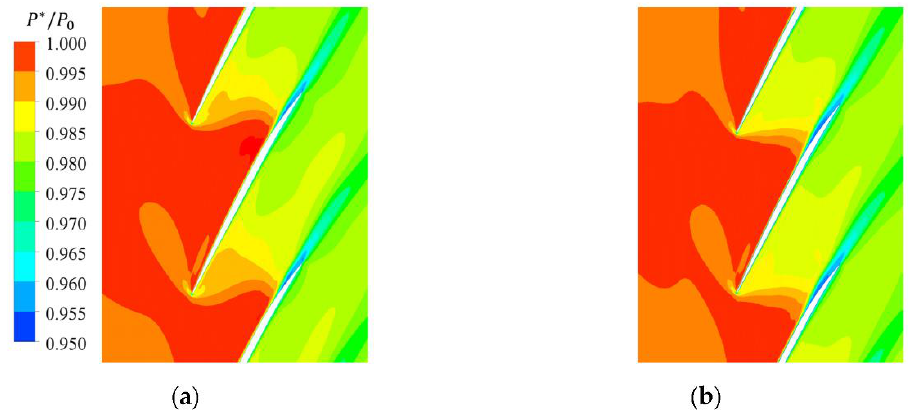
Figure 16. Comparison of Mach number contours in distortion region at 95% spanwise location. ( a ) DIS case; ( b ) COUP case.